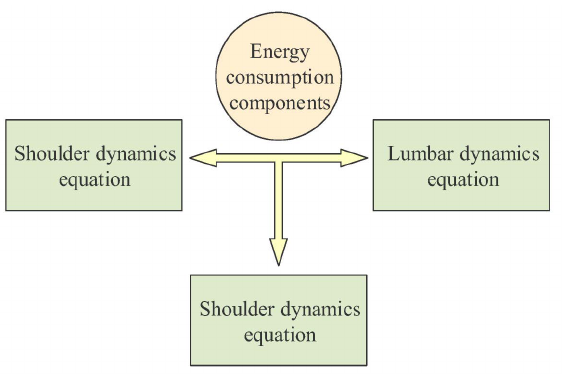
Figure 6. Energy consumption components.